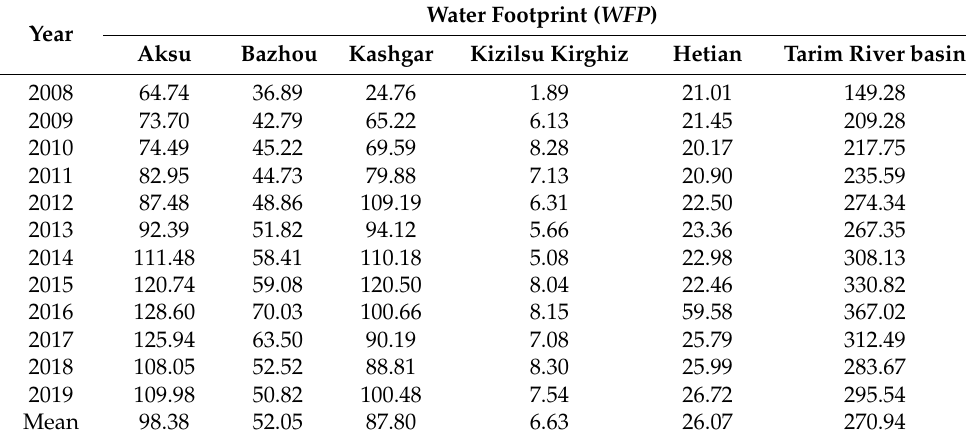
Table 3. Water footprint of Tarim River basin from 2008 to 2019 table locations. Unit: hundred million m 3 . Water Footprint ( WFP Year